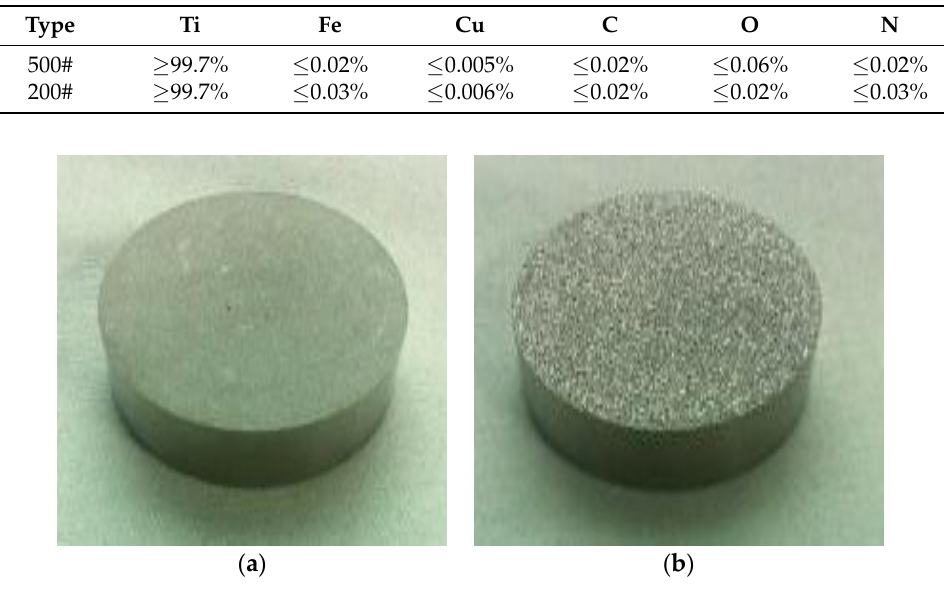
Figure 1. Preparation of porous titanium test samples: ( a ) specimen with small porosity; and ( b ) specimen with large porosity.